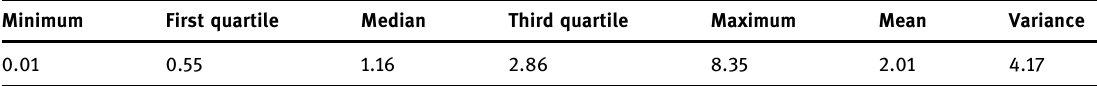
Table 2: Descriptive statistics for the survival data